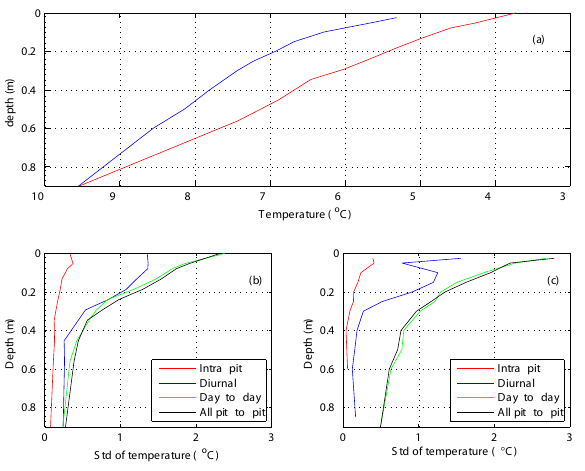
Fig. 3. Small-scale snow temperature observations near Basen nunatak: vertical profiles of (a) mean snow temperature in sum- mers 2006–2007 (red) and 2007–2008 (blue), (b) standard devia- tion of snow temperature at different scales in summer 2006–2007, and (c) summer 2007–2008.